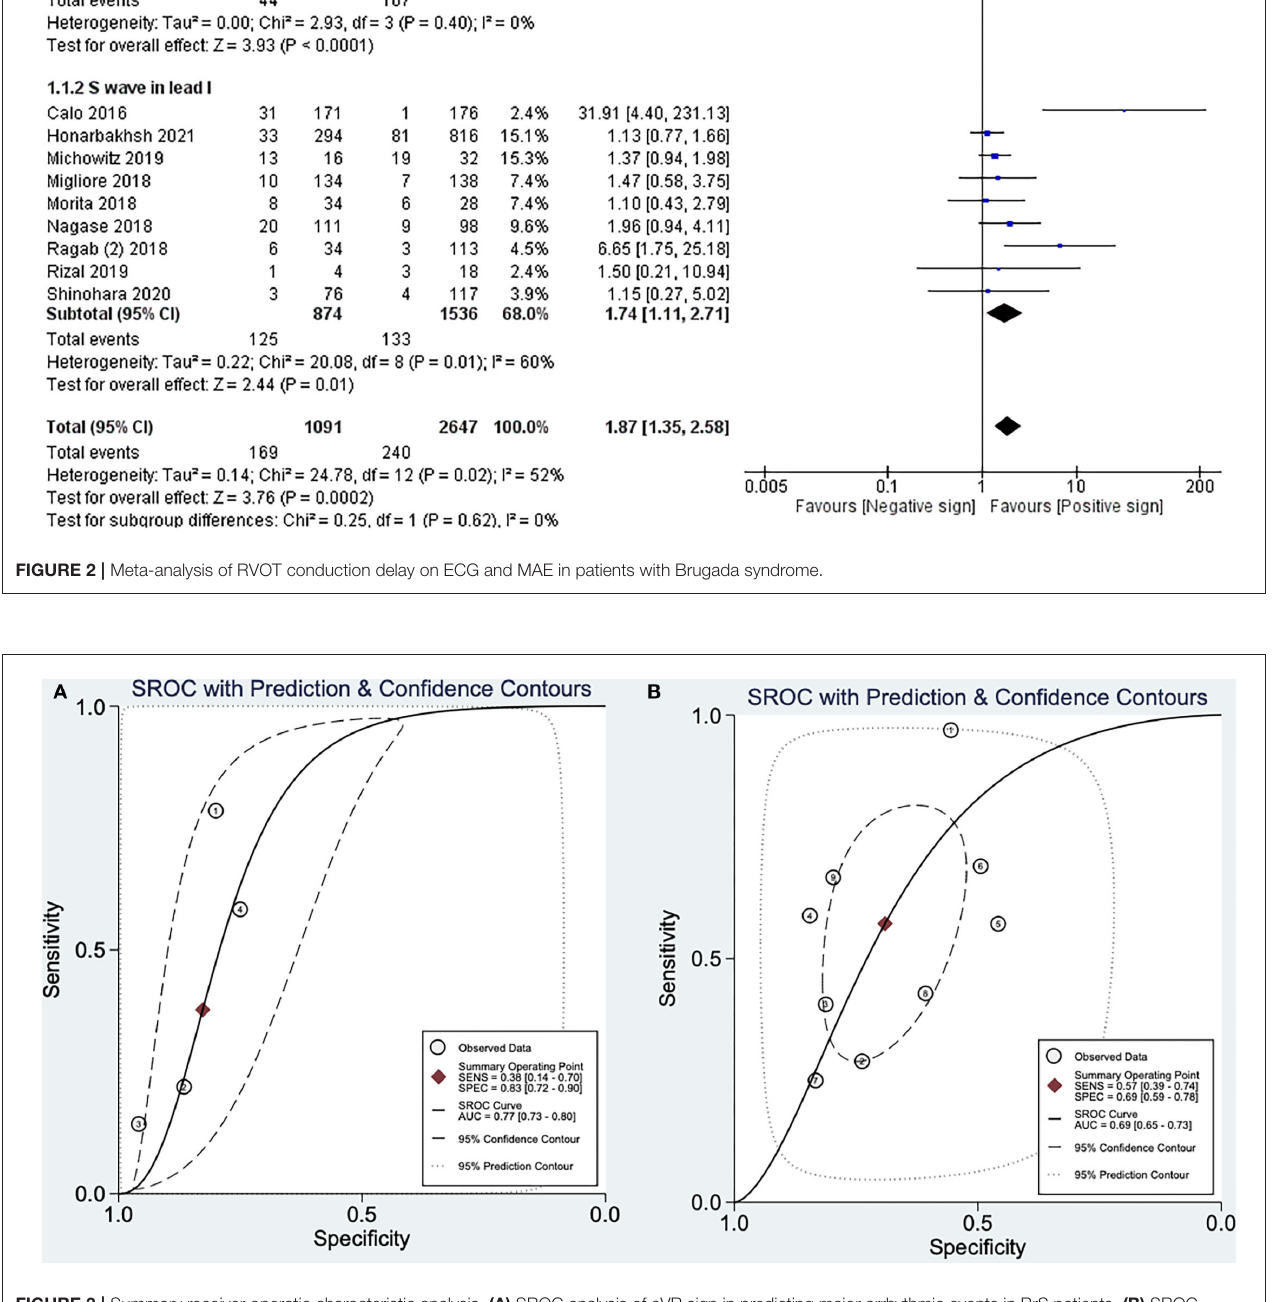
FIGURE 3 | Summary receiver operatic characteristic analysis. (A) SROC analysis of aVR sign in predicting major arrhythmic events in BrS patients. (B) SROC analysis of large S wave in lead I in predicting major arrhythmic events in BrS patients. SROC, summary receiver operating characteristic; AUC, area under curve; SENS, sensitivity; SPEC,